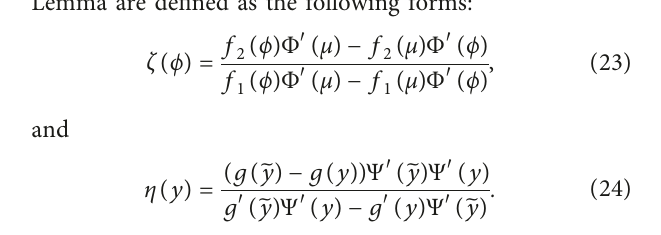
Figure 1: The phase portrait of equation (11)